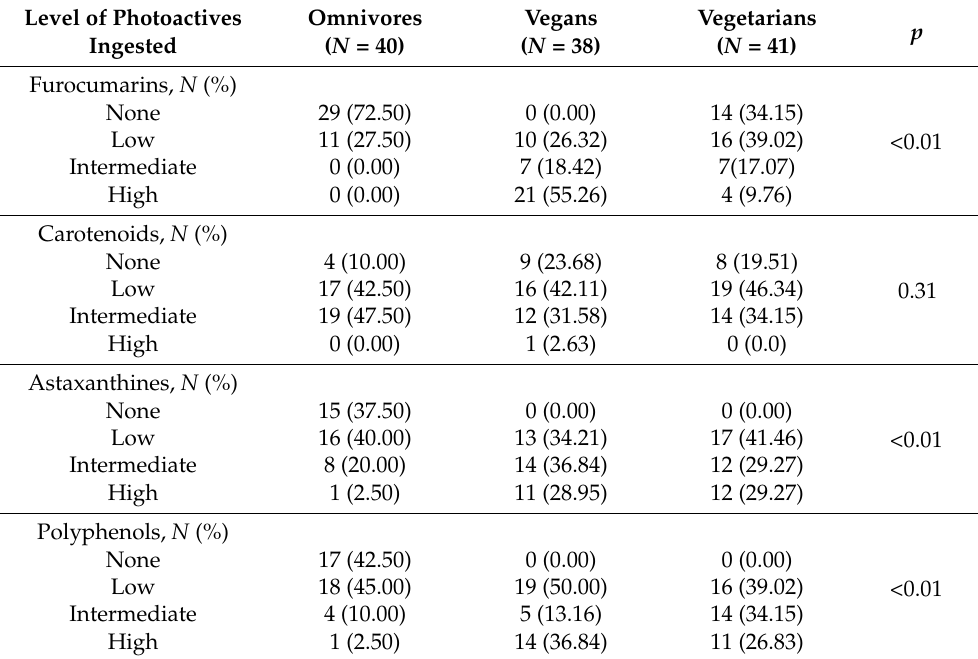
Table 2. Different intakes of the main photoactives between omnivores, vegetarians and vegans. Level of Photoactives